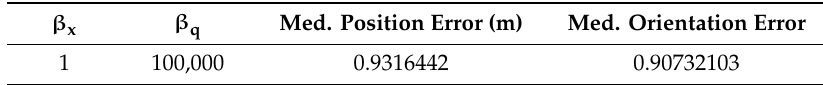
Figure 7. Experimental results from varying the orientation scaling coefficient in the exponential- based model. Table 3. Fine-tuning errors of the exponential-based model.